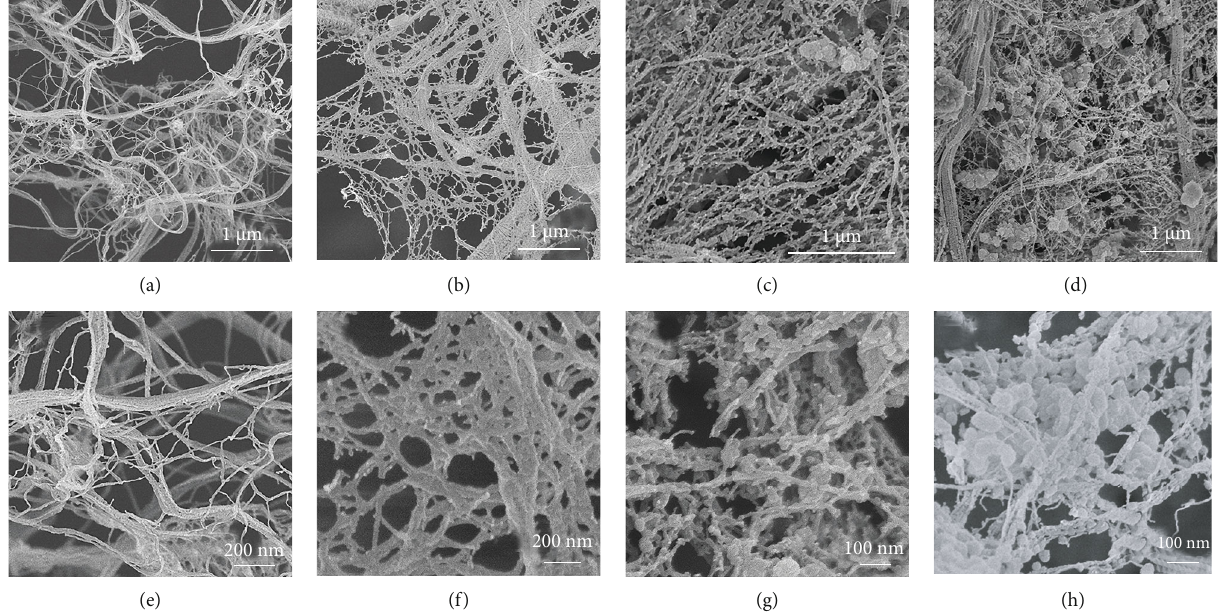
Figure 1: (a) – (d) SEM images of 0.2PDA@CNF, 0.5PDA@CNF, 1PDA@CNF, and 2PDA@CNF, respectively; (e) – (h) corresponding high- magni fi cation images of (a) –